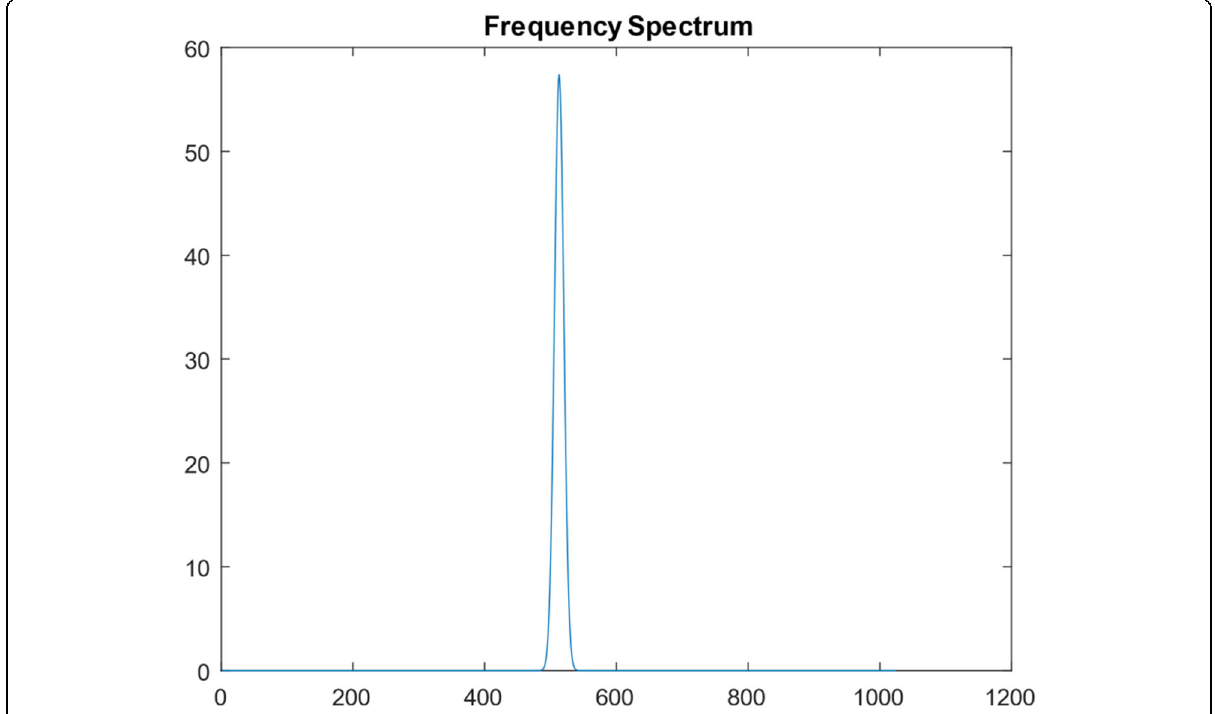
Fig. 11 The frequency spectrum of the true Gaussian function